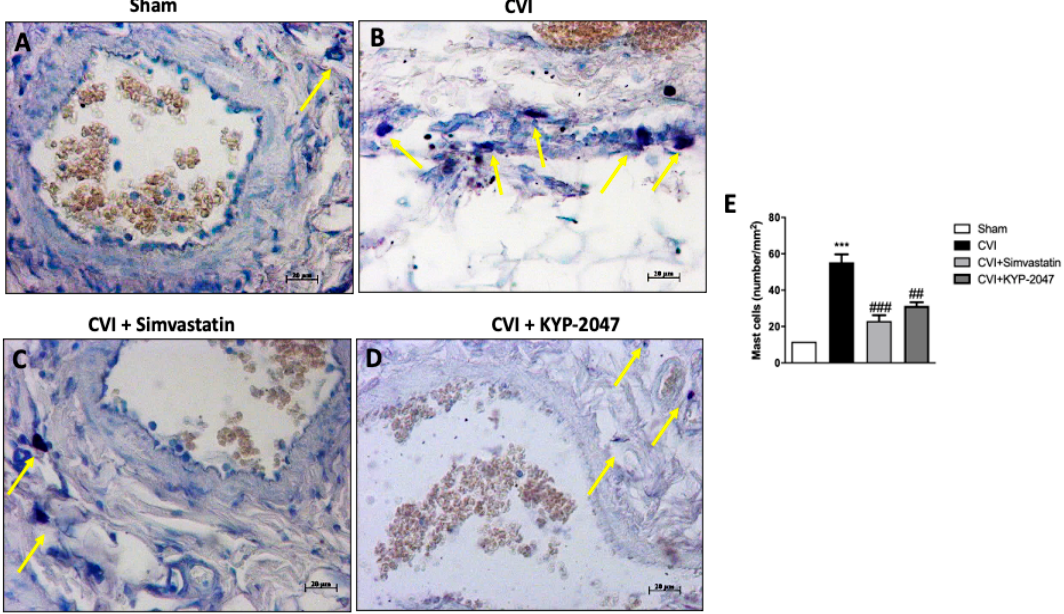
Figure 7. Treatment with KYP-2047 treatment on mast cells. Mast cells were evaluated in saphene veins tissues by staining with toluidine blue. Compared with sham animals, the mast cells number in CVI-damaged group was significantly increased (respectively, ( A ), ( B ), see graph ( E ). Neutrophilic accumulation was appreciably reduced by KYP-2047 or Simvastatin treatment (respectively, ( C ), ( D ), see graph Figure 3E). Yellow arrows indicated the mast cells presented in the area. Scale bar for figures F-I: 20 µm, magnification 40 ×.Data represent the means of at least three independent experiments. One way ANOVA followed by Bonferroni post-hoc. *** p < 0.001 versus Sham; ## p < 0.01 and ### p < 0.001 versus CVI.